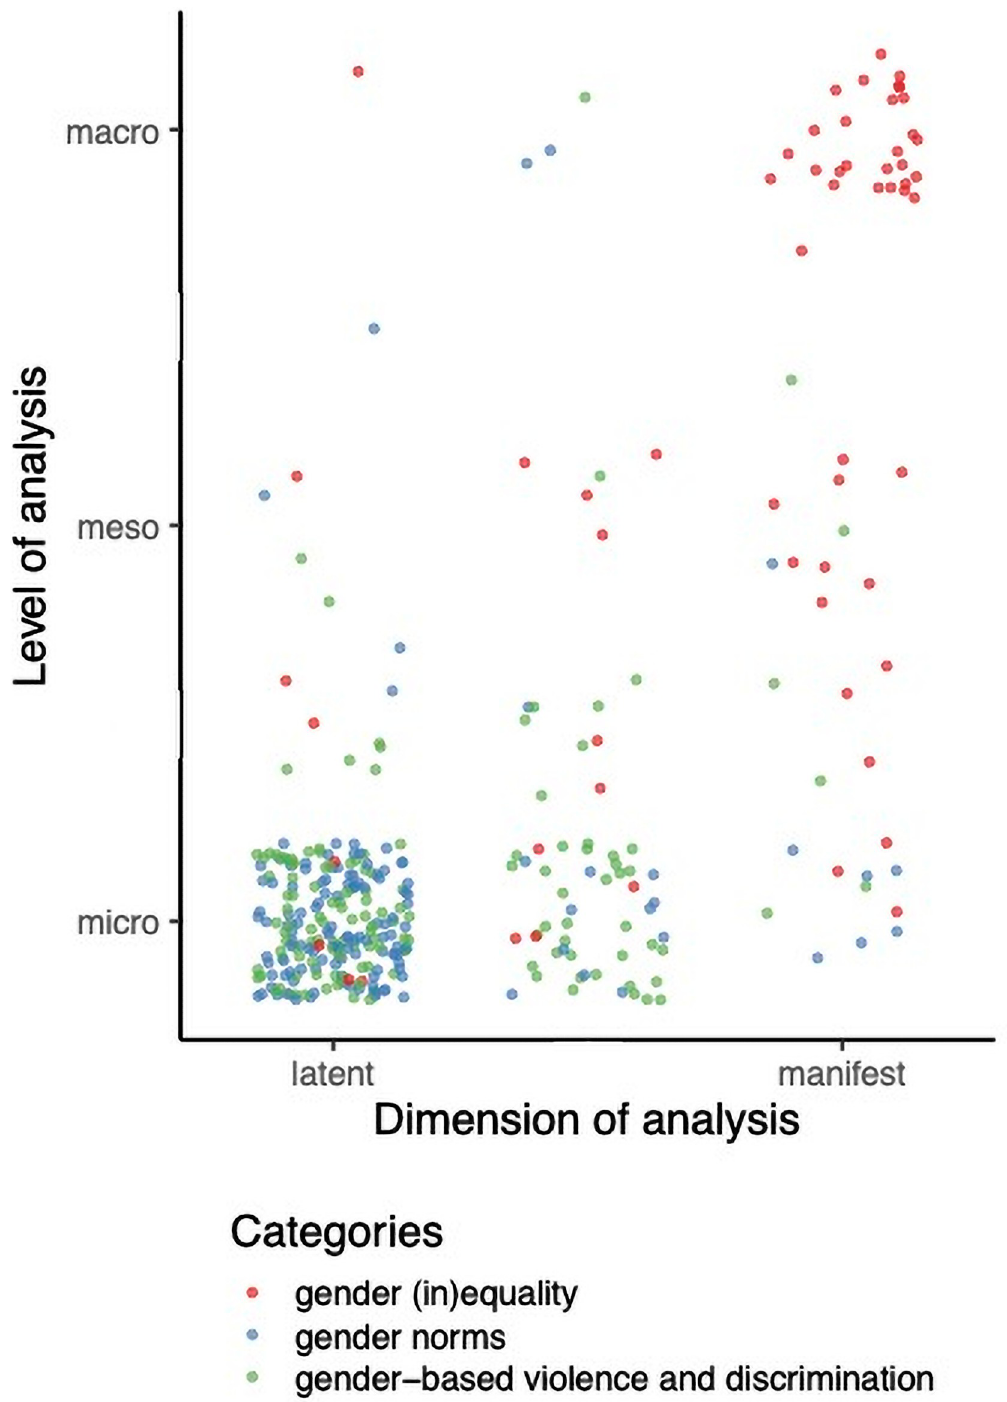
Fig 3. Multilevel mapping of gender measures used in epidemiology. Source: Authors’ own elaboration.